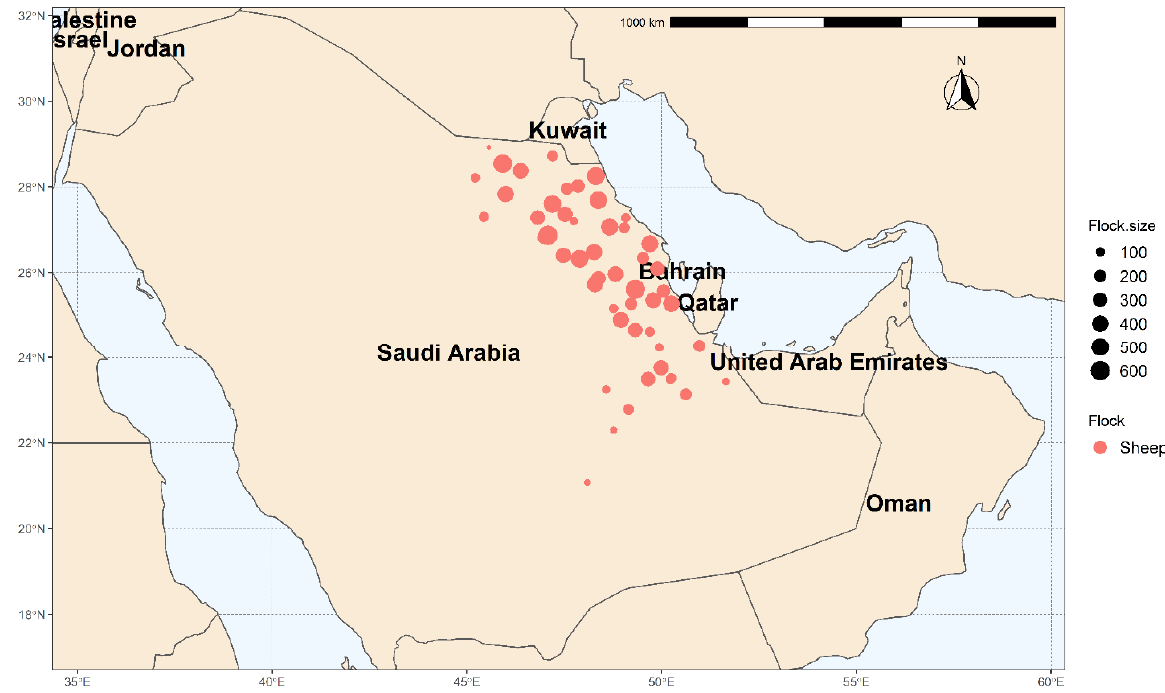
Figure 1. The location and size of tested flocks in Eastern Province, Saudi